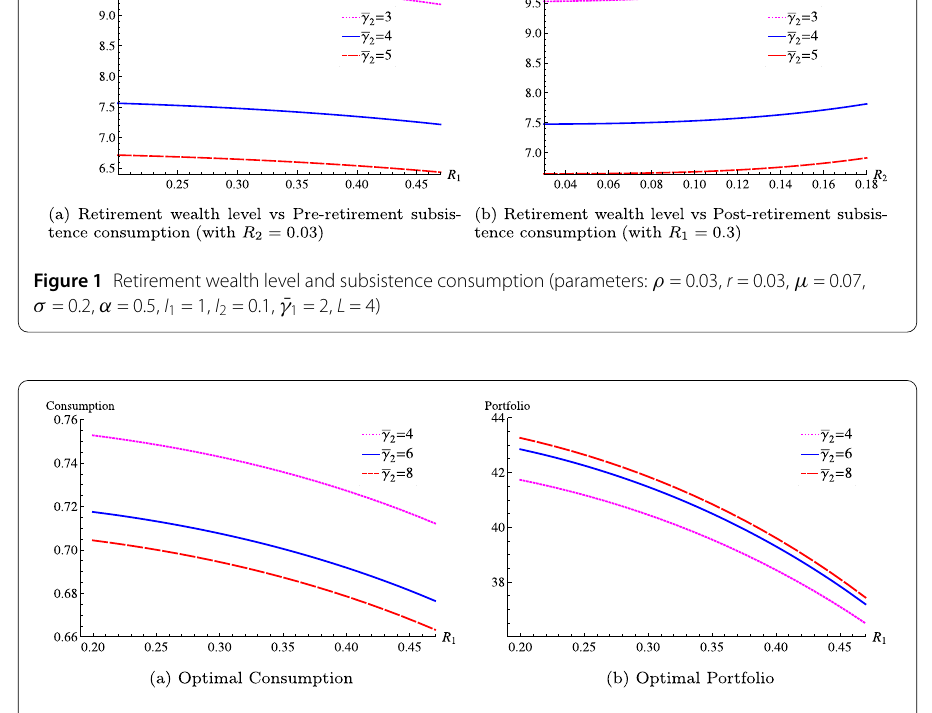
Figure 2 Combined effects of risk aversion change and subsistence consumption on pre-retirement optimal consumption and portfolio at the wealth level 4 (parameters: ρ = 0.03, r = 0.03, μ = 0.07, σ = 0.2, α = 0.5, I 1 = 1, I 2 = 0.1, R 2 = 0.03, ¯ γ 1 = 2, L =